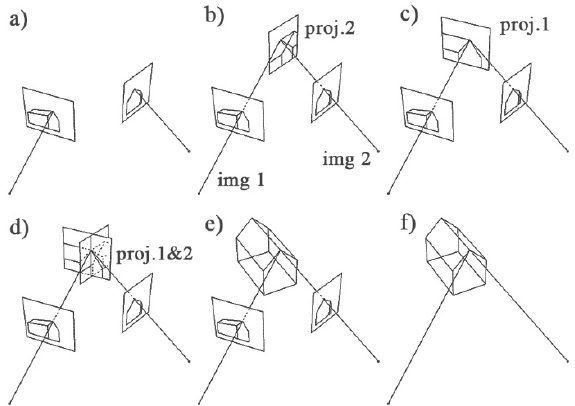
Figure 2. The process of modelling using central projection of oriented images a) projecting two different images b), c) & d) moving the projections to find the intersection, which means a triangulation e), & f) completing the model of the architecture. Even the geometry and the dimensions of the monument has a very important influence on the result.